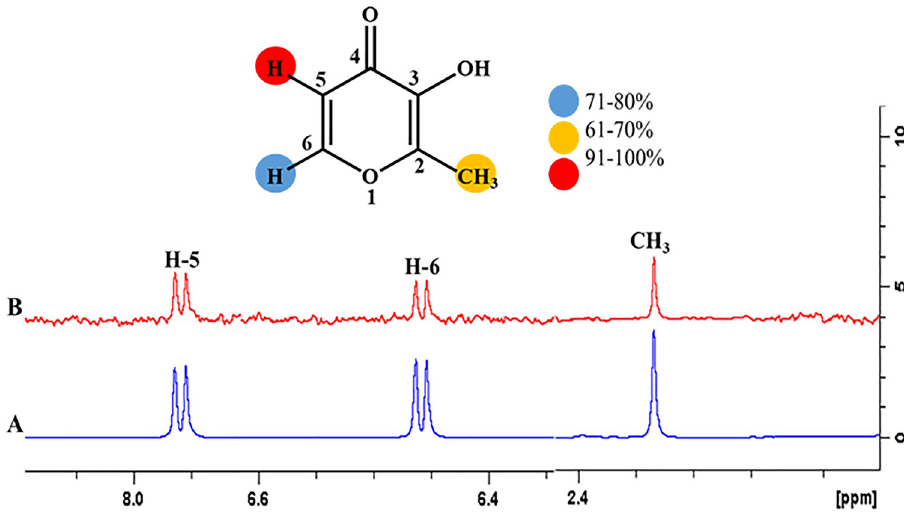
Fig 19. (A) Reference 1 H-NMR spectrum of ligand 4 . (B) Difference spectrum of ligand 4 with the